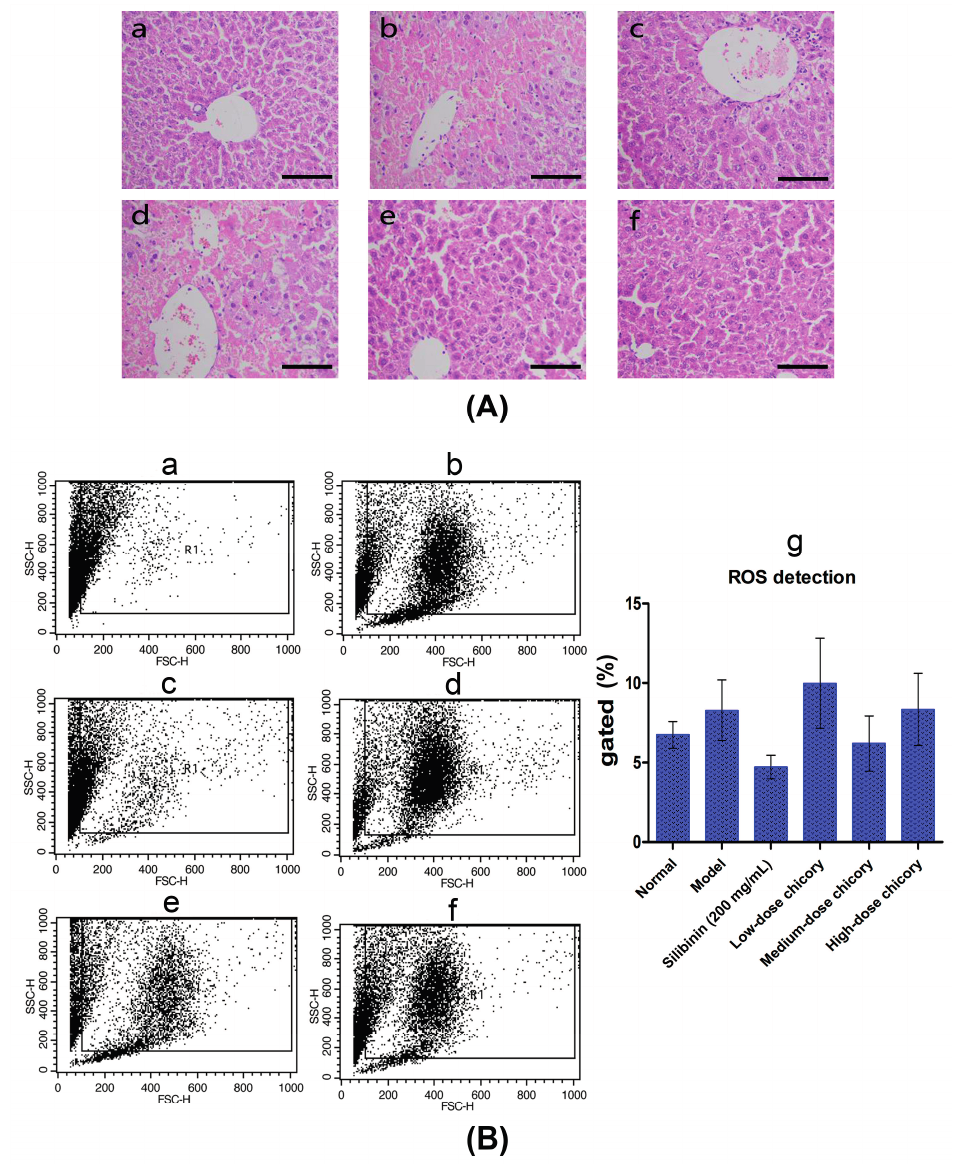
Figure 2. ( A ) Liver tissue histopathological observation results, ( a ) normal control; ( b ) liver injury model; ( c ) positive drug silibinin control (200 mg/mL); ( d ) low-dose drug group (2.0 g/kg chicory); ( e ) middle-dose group (6.0 g/kg chicory); and ( f ) high-dose group (18.0 g/kg chicory); and scale bar = 100 μ m; ( B ) ROS detection result, ( a ) normal control; ( b ) liver injury model; ( c ) positive drug silibinin control (200 mg/mL); ( d ) low-dose drug group (2.0 g/kg chicory); ( e ) middle-dose group (6.0 g/kg chicory); ( f ) high-dose group (18.0 g/kg chicory); and ( g ) quantitative analysis of ROS detection. FSC-H and SSC-H represent cell numbers and fluorescence intensity,